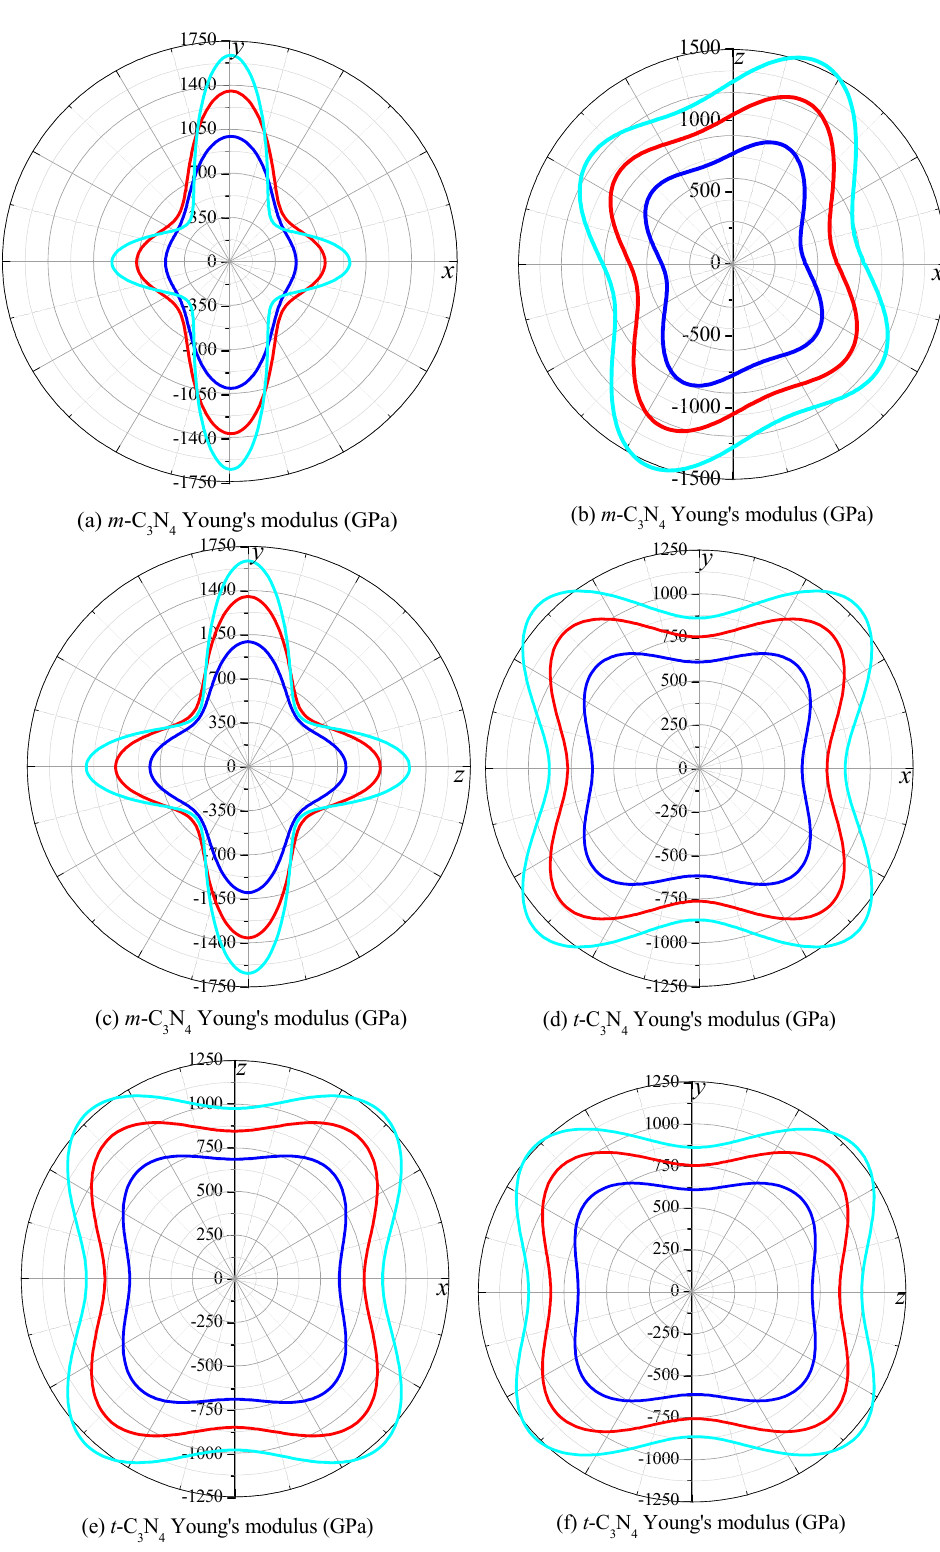
Figure 9. 2D representation of Young’s modulus in the xy plane, xz plane and yz plane for: m -C 3 N 4 ( a – c ); and t -C 3 N 4 ( d – f ). The blue, red and cyan lines represent Poisson’s ratio at p = 0, 50 and 100 GPa, respectively.